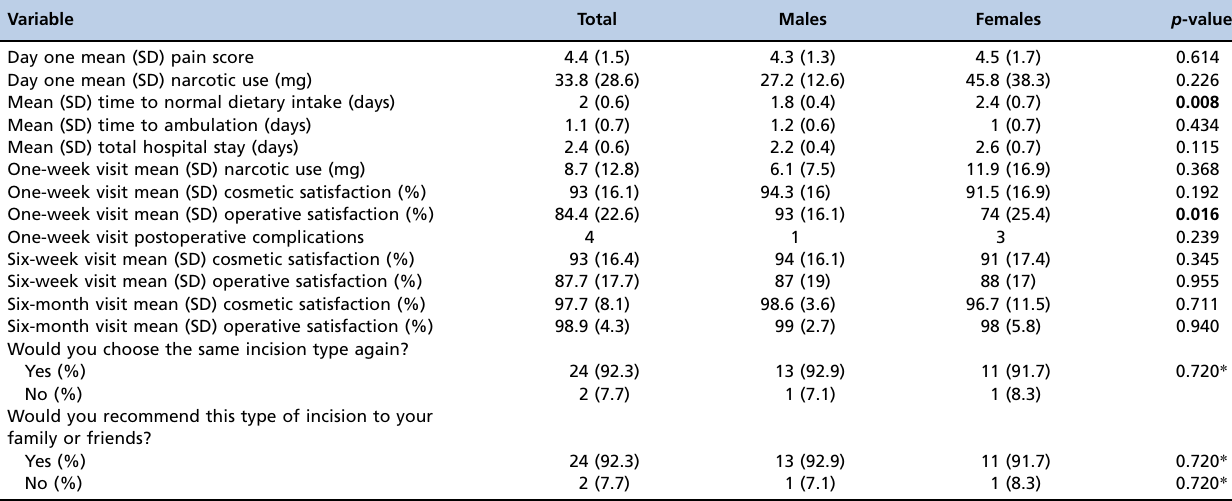
Table 2 - Postoperative